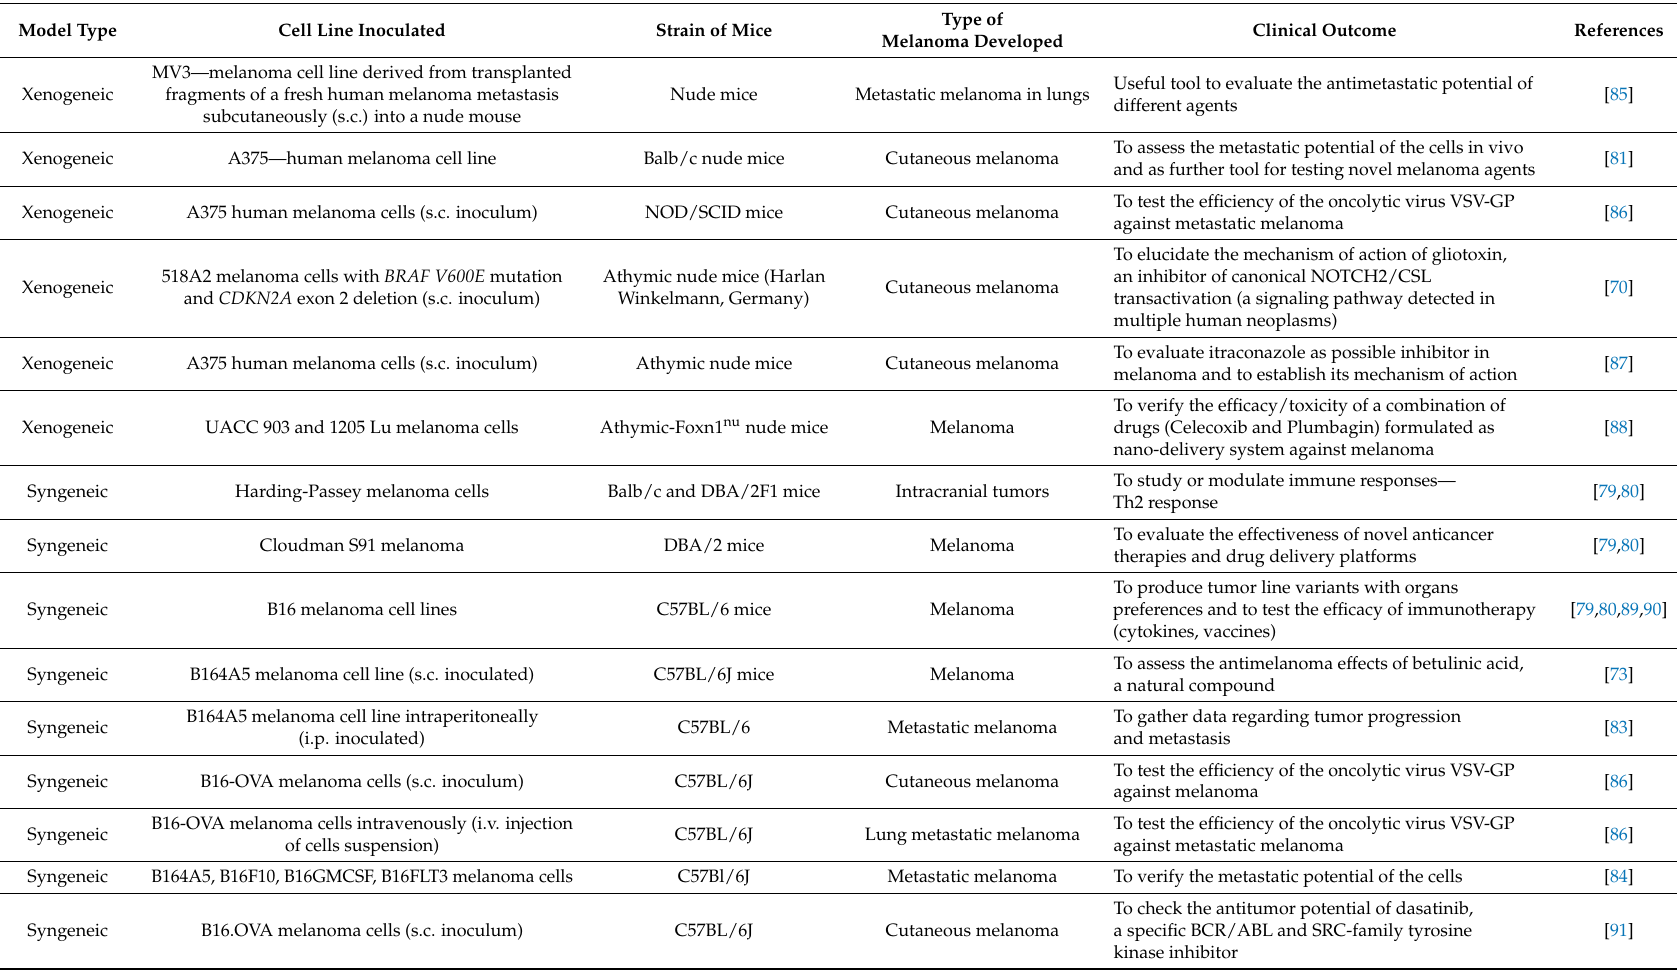
Table 1. Several examples of xenotransplanted (xenogeneic and syngeneic) melanoma mouse